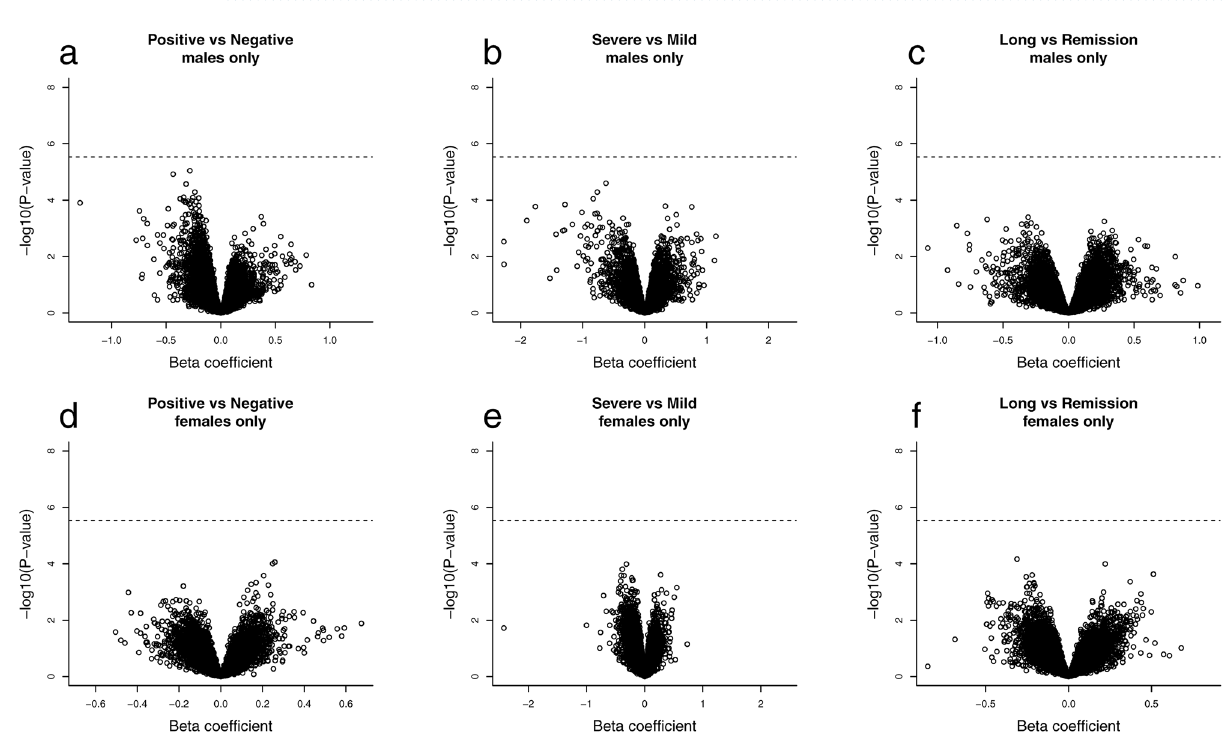
Figure 6. Volcano plots for the sex-stratified analyses targeting sex-chromosome probes. The plots display the estimated beta coefficients against -log 10 of the P-values. Panels ( a ) to ( c ) are for males only and panels ( d ) to ( f ) are for females only. Panels ( a ) and ( d ) show the results of the COVID-19 positive (n = 109) versus COVID-19 negative (n = 73) comparison. Panels ( b ) and ( e ) show the results of the severe COVID-19 (n = 61) versus mild COVID-19 (n = 48) comparison. Panels ( c ) and ( f ) show the results of the long-COVID (n = 41) versus remission (n = 63) comparison. The dotted horizontal line indicates the Bonferroni threshold (0.05/17,183 CpG sites for males and 0.05/17,128 CpG sites for